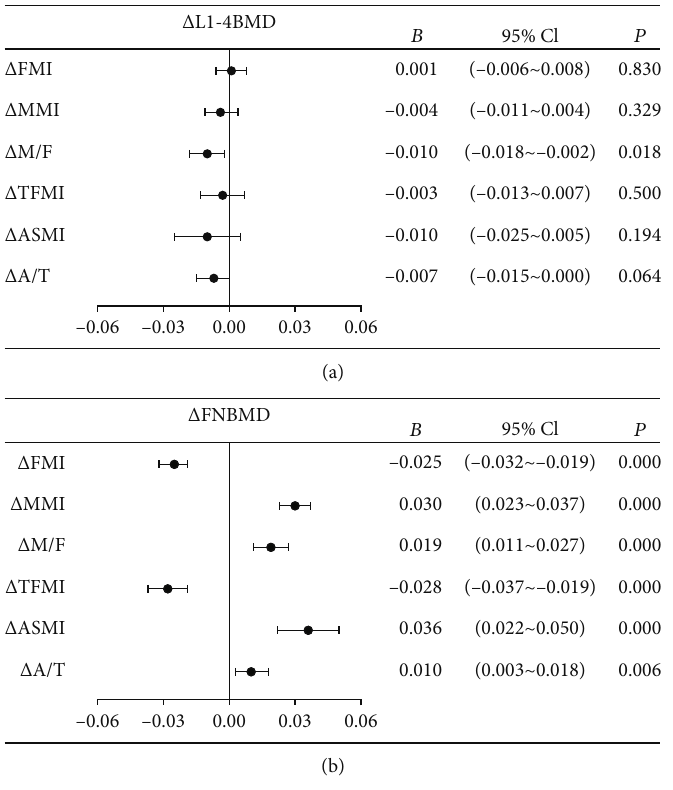
Figure 2: Linear regression analysis of body composition index, L BMD, and FNBMD. Note: adjusted: age, sex, course of T2DM, chronic 1-4 complications of T2DM, BMI, FBG, HbA1c, TG, LDL-C, HDL-C, SBP, DBP, and medication history. FMI: fat mass index; MMI: muscle mass index; M/F: muscle/fat mass ratio; TFMI: trunk fat mass index; ASMI: appendicular skeletal muscle mass index; A/T: appendicular skeletal muscle mass/trunk fat mass